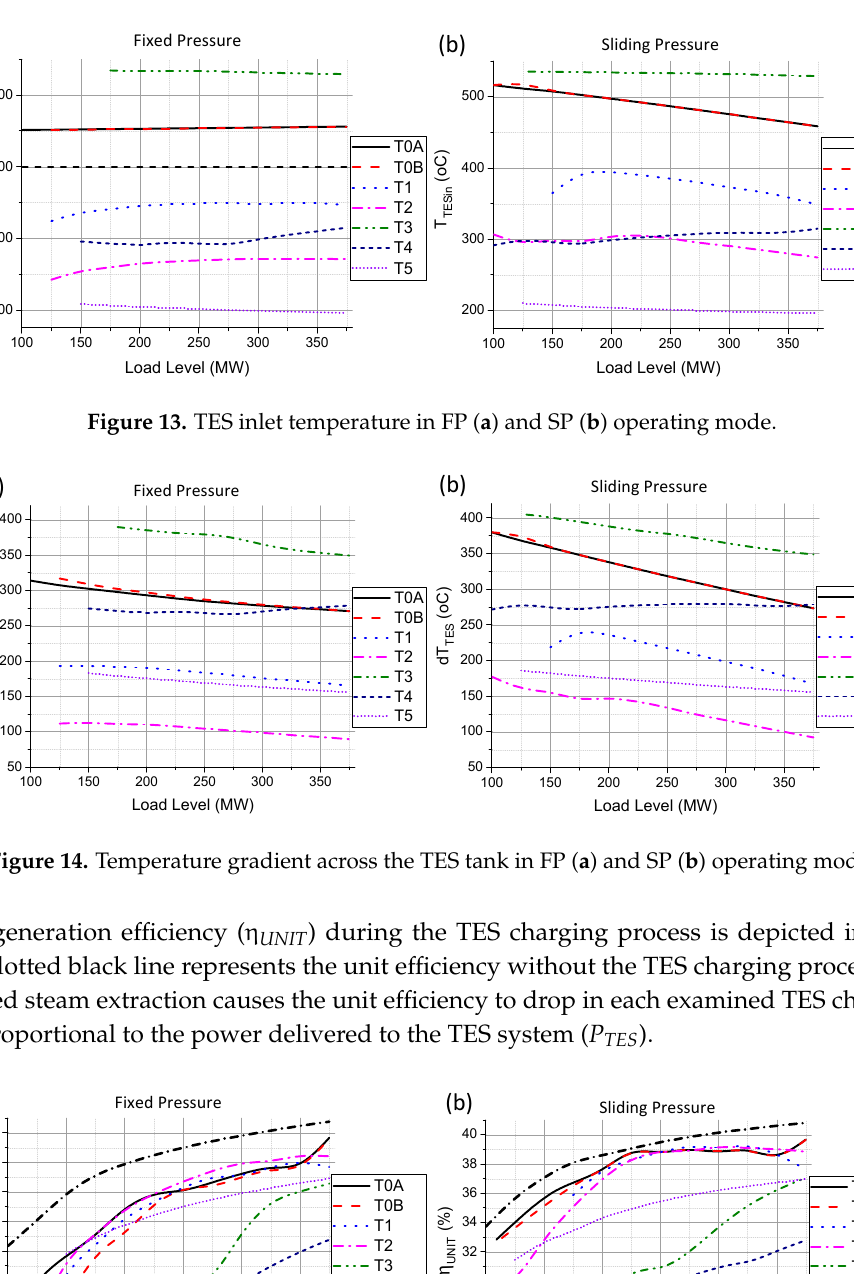
Figure 15. Unit efficiency ( η UNIT ) in FP ( a ) and SP ( b ) operating mode.